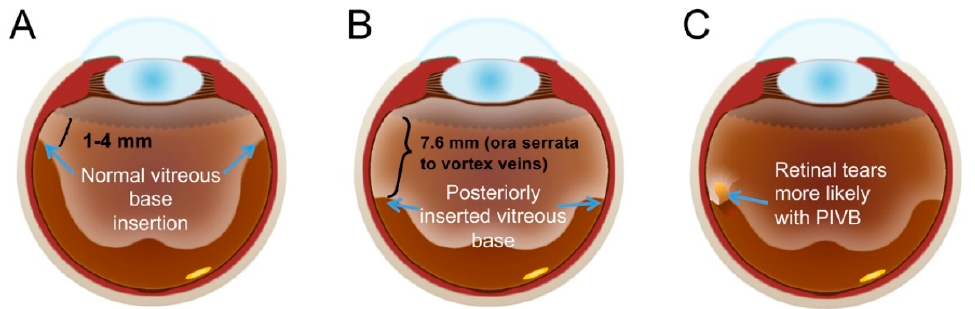
Figure 6. Schematic of vitreous base inserting into the retina. At the pars plana normally ( A ), when it is posteriorly inserted ( B ), or at posterior the equator, averaging 7.6 mm posterior to the ora serrata which predisposes to more retinal tears ( C ). Adapted from Sohn et al. [111].